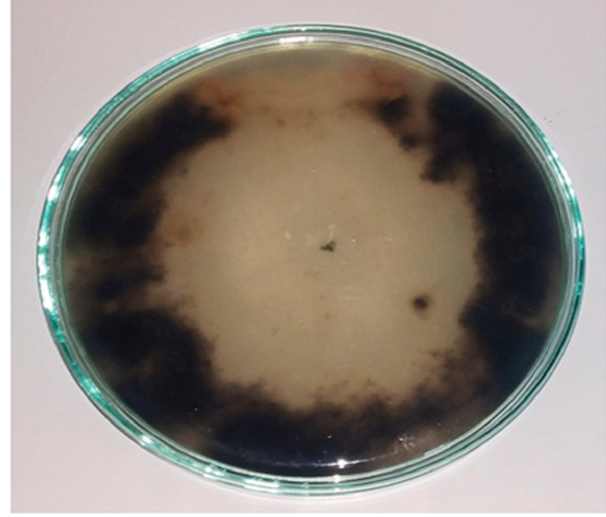
Figure 5. Antagonistic effect between Alternaria cerealis (MT808477) tomato ( S. lycopersicum L.) leaf spot pathogen and saprophytic Trichoderma harzianum , showing growth inhibition of A. cerealis .